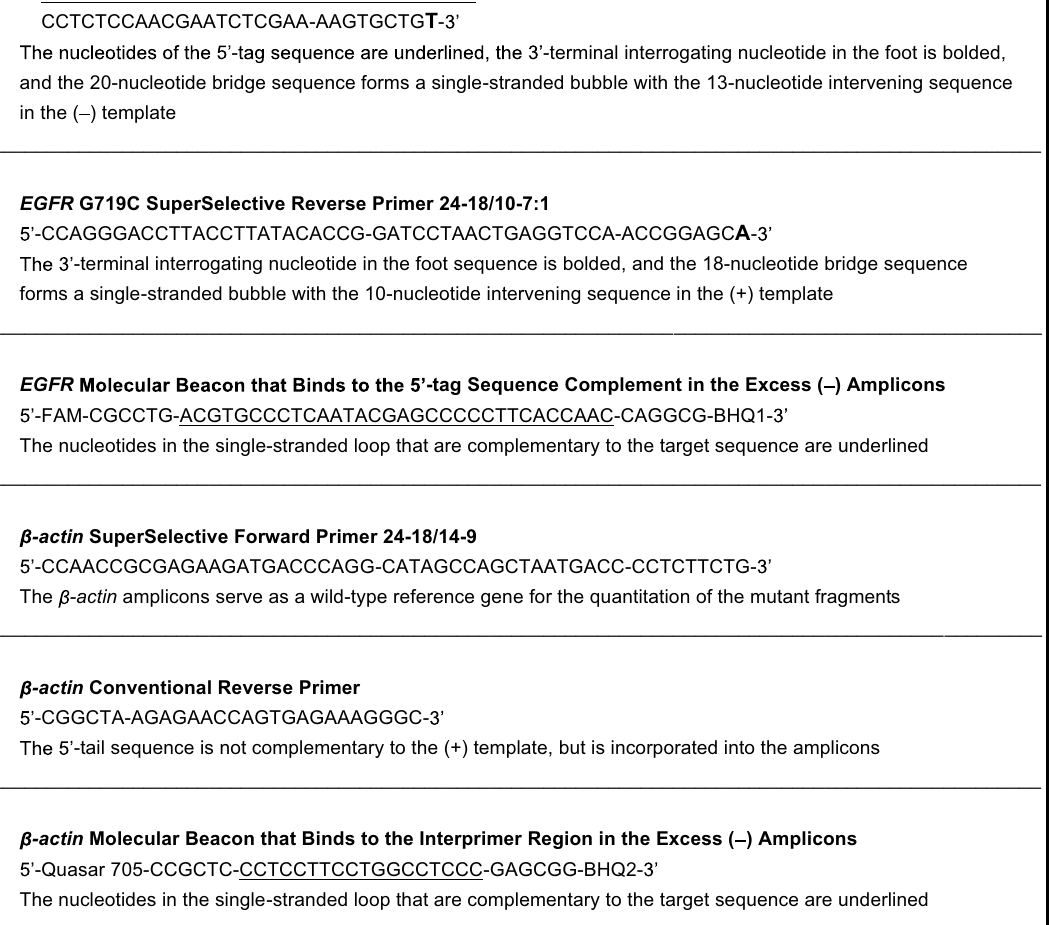
-ACGTGCCCTCAATACGAGCCCCCTTCACCAAC-TCTCTTGAGGATCTTGAAGGAAACTGAA- CCTCTCCAACGAATCTCGAA-AAGTGCTG T - - -terminal interrogating nucleotide in the foot is bolded, and the 20-nucleotide bridge sequence forms a single-stranded bubble with the 13-nucleotide intervening sequence in the ( ) template _________________________________________________________________________________________________